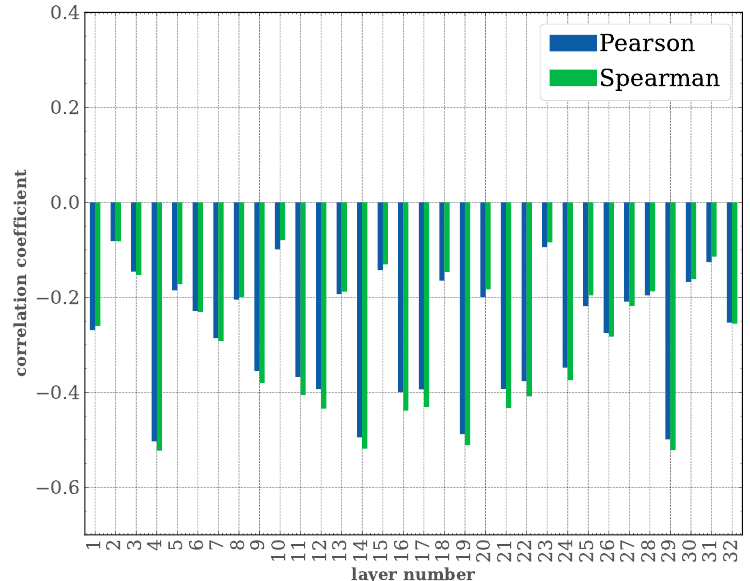
Figure 17. Correlation coefficient for tensile KDF related to fiber orientation aligned maximum